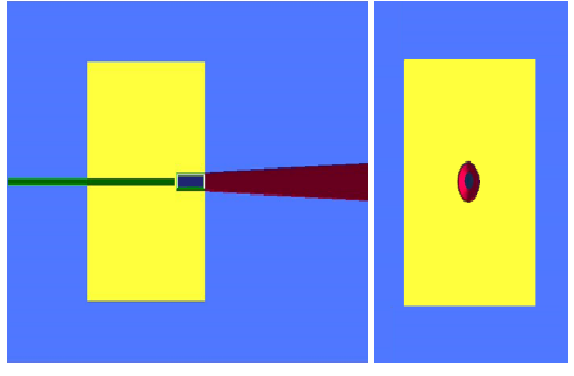
Fig. 9. CNS model prepared in Geant4.